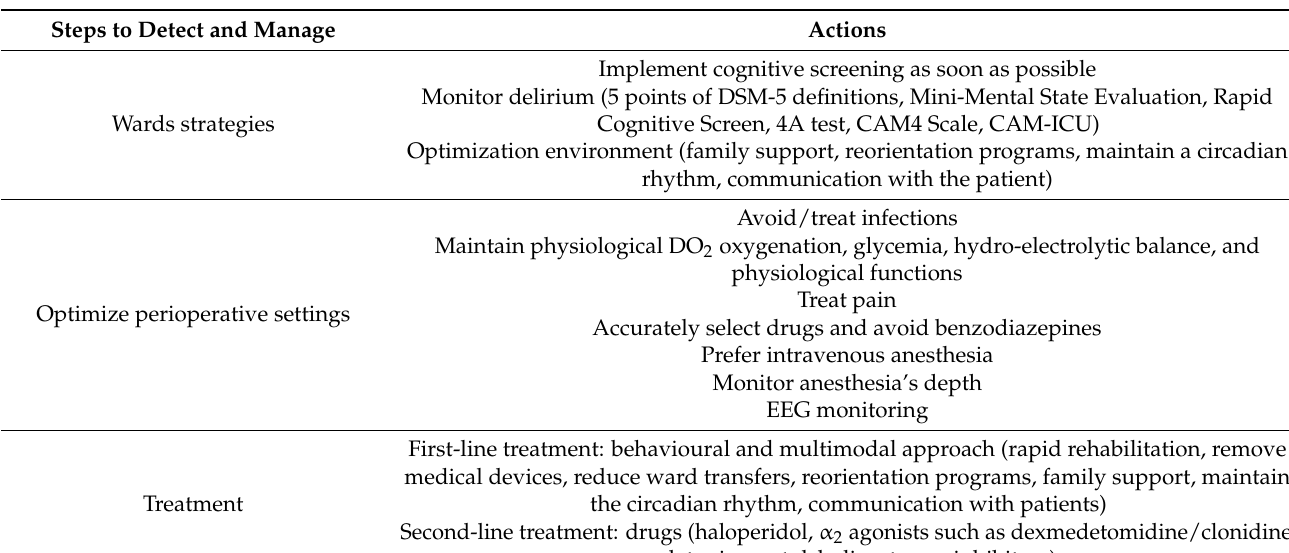
Table 3. The essential points to detect and manage postoperative delirium.